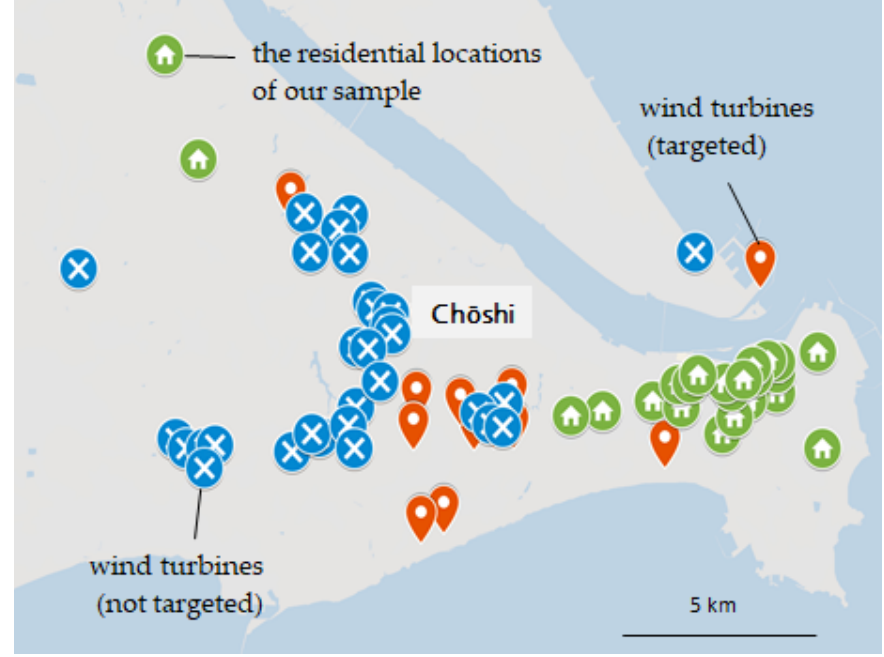
Figure 2. Map of Ch ō shi area and locations of wind